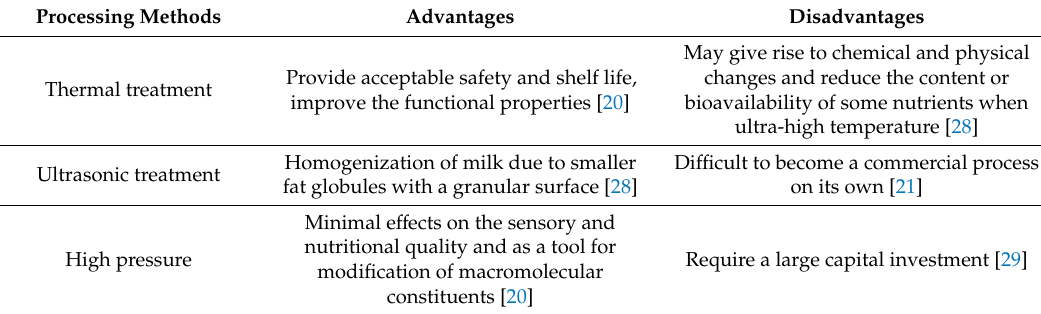
Table 1. Advantages and disadvantages of various milk processing